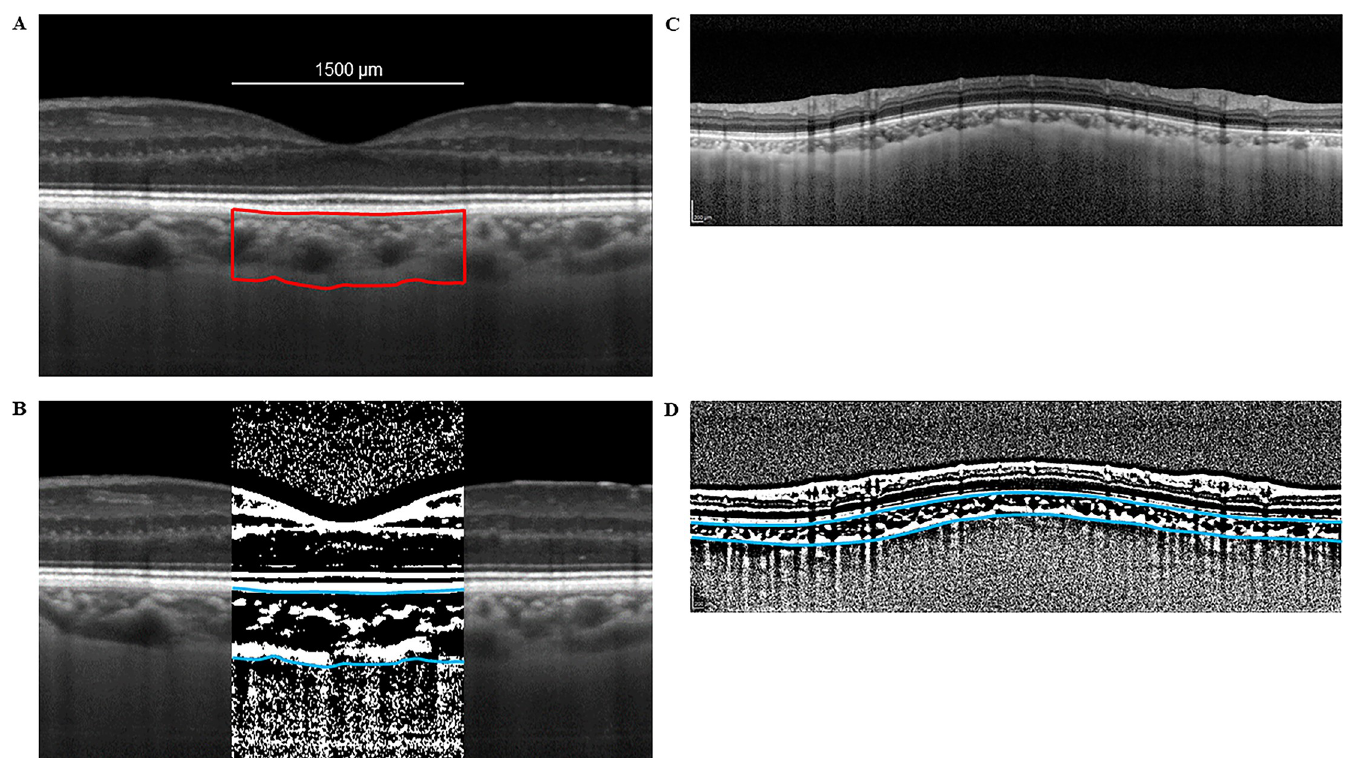
Fig 1. Enhanced depth imaging OCT image and converted binary image of the eye of a glaucoma patient. The EDI-OCT images in the macular area (A) or the peripapillary area (C) were converted to binary images (B, D) using ImageJ software. The luminal (dark area) and interstitial areas are seen. The area between the blue lines indicates the measurement area of the